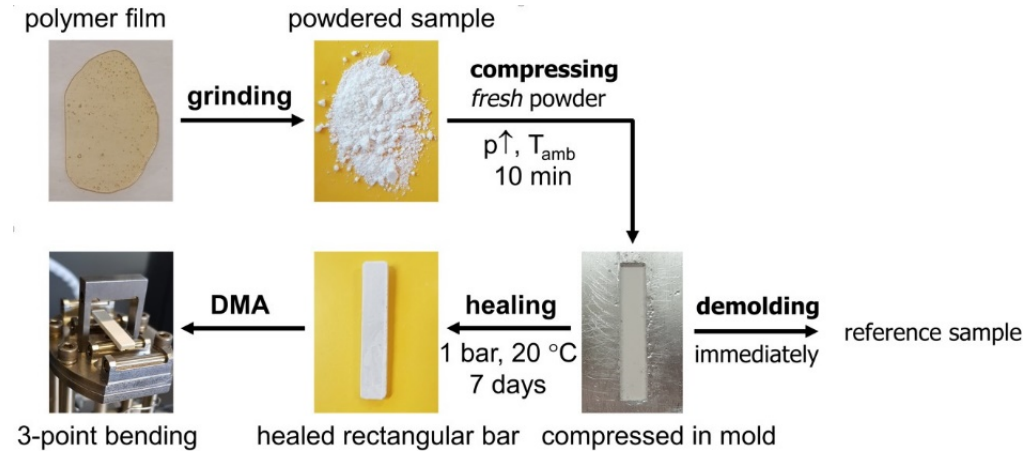
Figure 13. Self ‐ healing of 3M ‐ F375PMA at 20 °C. A polymer film is ground into fine powder, Figure 13. Self-healing of 3M-F375PMA at 20 ◦ C. A polymer film is ground into fine powder, compressed compressed in a metal mold at elevated pressure at T amb for 10 min, demolded after self ‐ healing for in a metal mold at elevated pressure at T amb for 10 min, demolded after self-healing for seven days at seven days at 1 bar and 20 °C, and analyzed by DMA in 3 ‐ point bending mode. A reference is 1 bar and 20 ◦ C, and analyzed by DMA in 3-point bending mode. A reference is prepared by immediate prepared by immediate demolding after compression. demolding after compression.